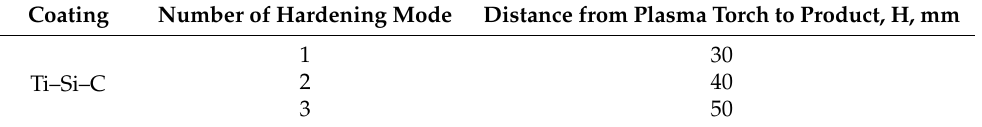
Table 1. Sample treatment